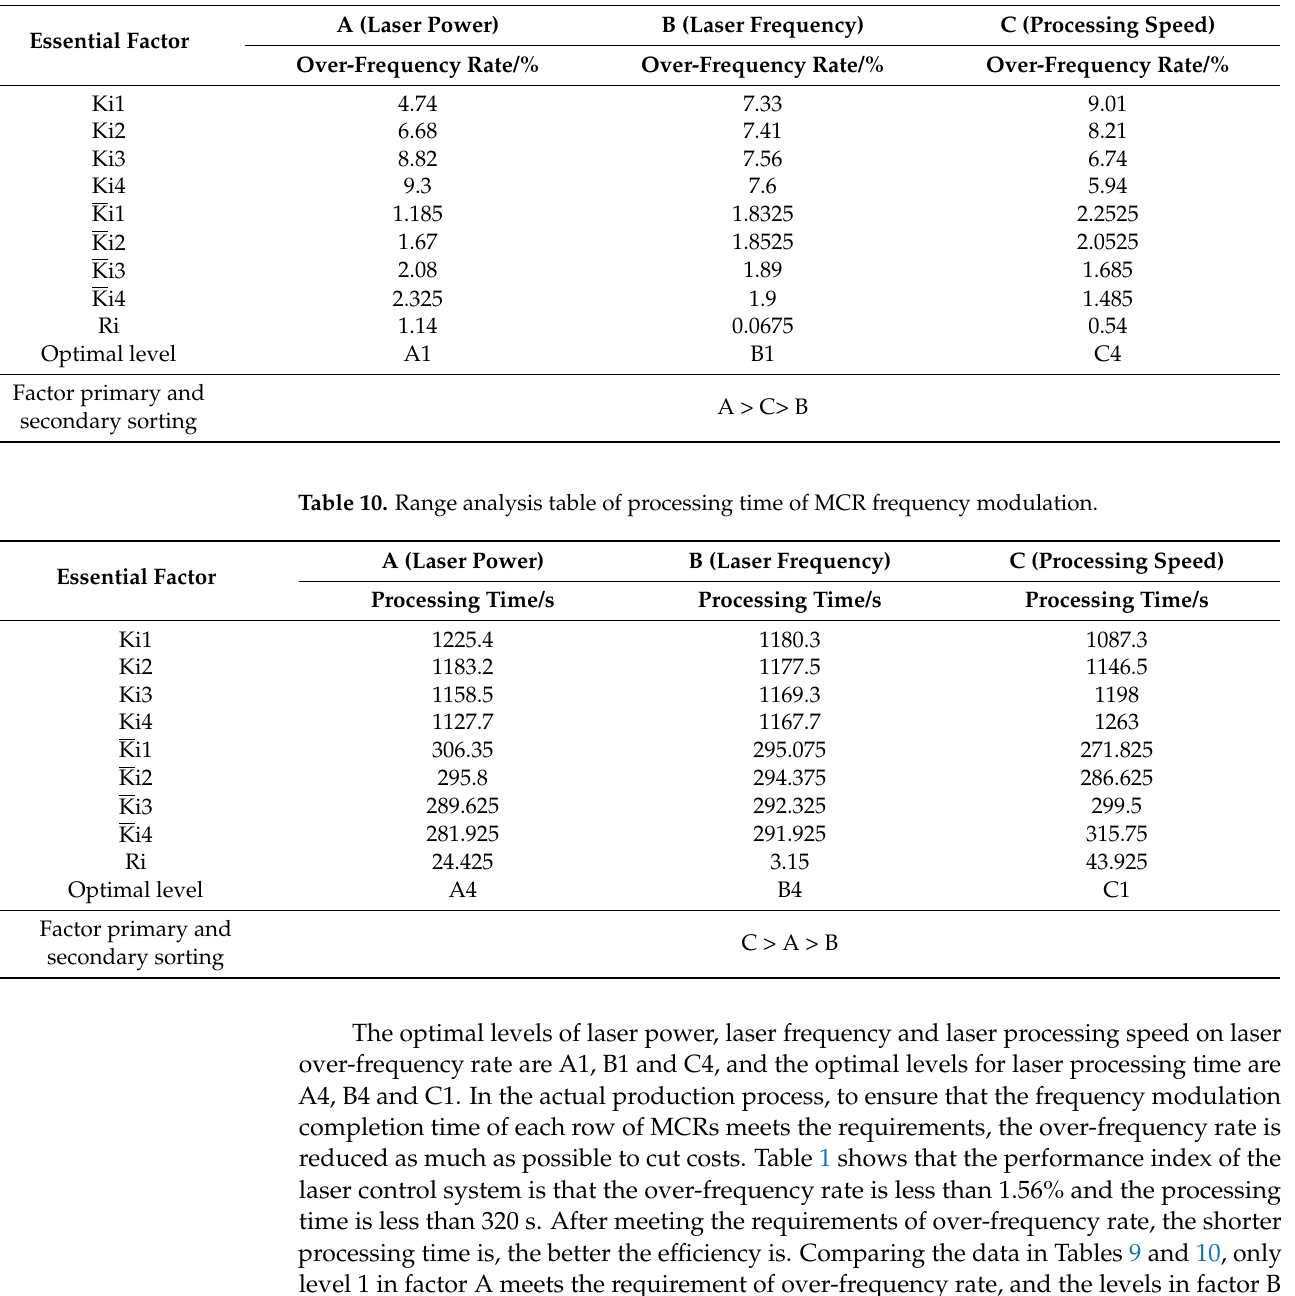
Table 9. Range analysis table of over-frequency rate of MCR frequency modulation.